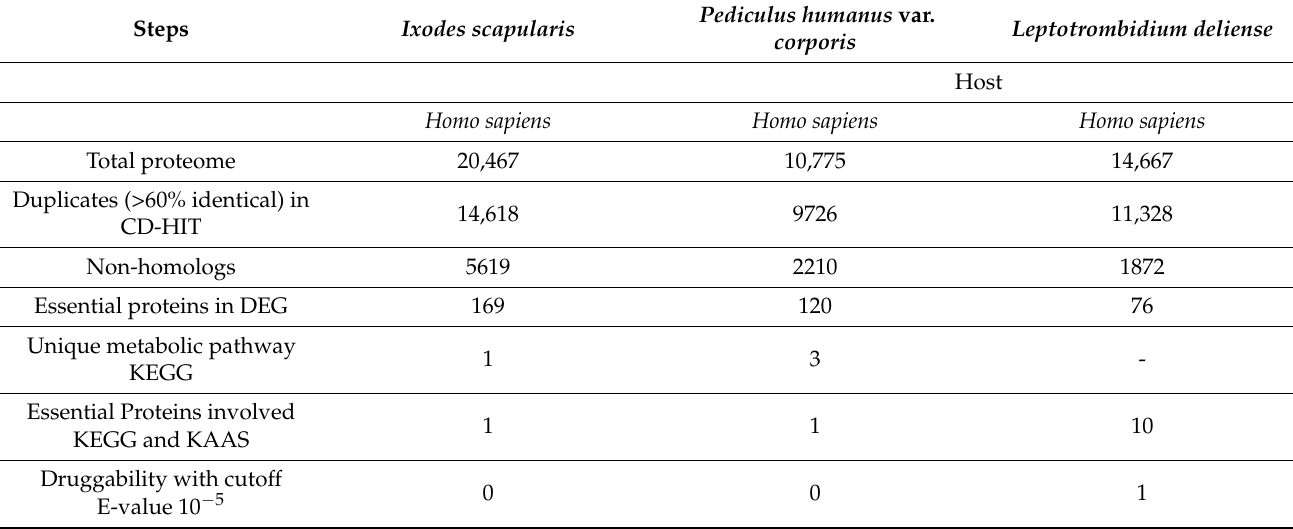
Table 1. The stepwise analysis and their result of selected